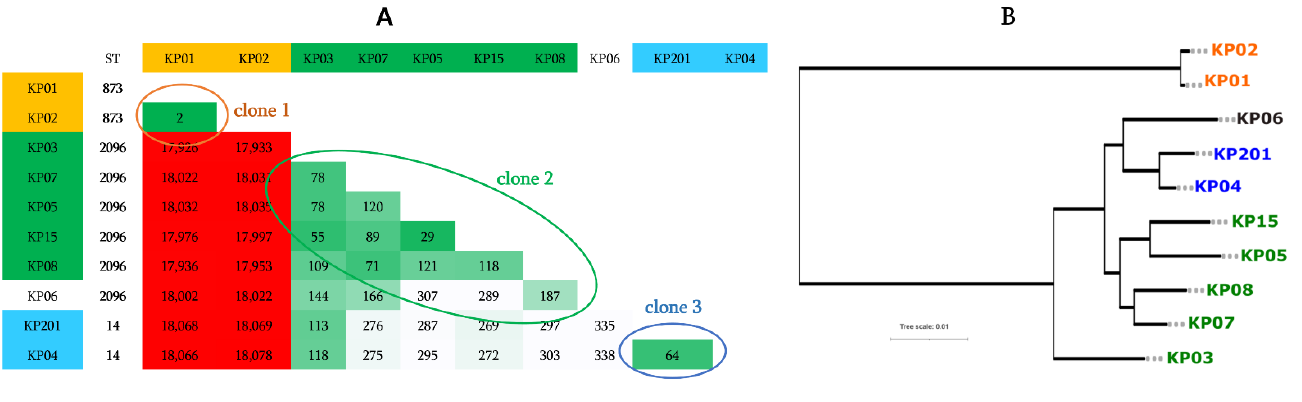
Figure 3. Genomic characterization of K. pneumoniae isolates. ( A ) Pairwise comparison of genomic gSNPs of K. pneumoniae showing the three distinguished sub-clones; ( B ) whole-proteome-based phylogenetic tree of K. pneumoniae isolates.